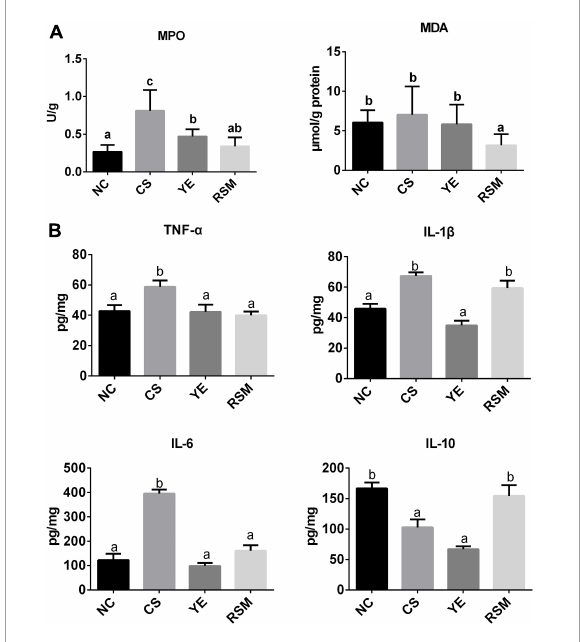
FIGURE2 Effects of two algal oils on MDA, MPO (A) and cytokines levels (B) in the colon tissue for the tested mice. Data ( n = 9 per group) are expressed as mean ± SEM; groups with different letters statistically differ. Groups with the same letter are considered to have no significant differences, groups with different letters are significantly different from each other ( P <